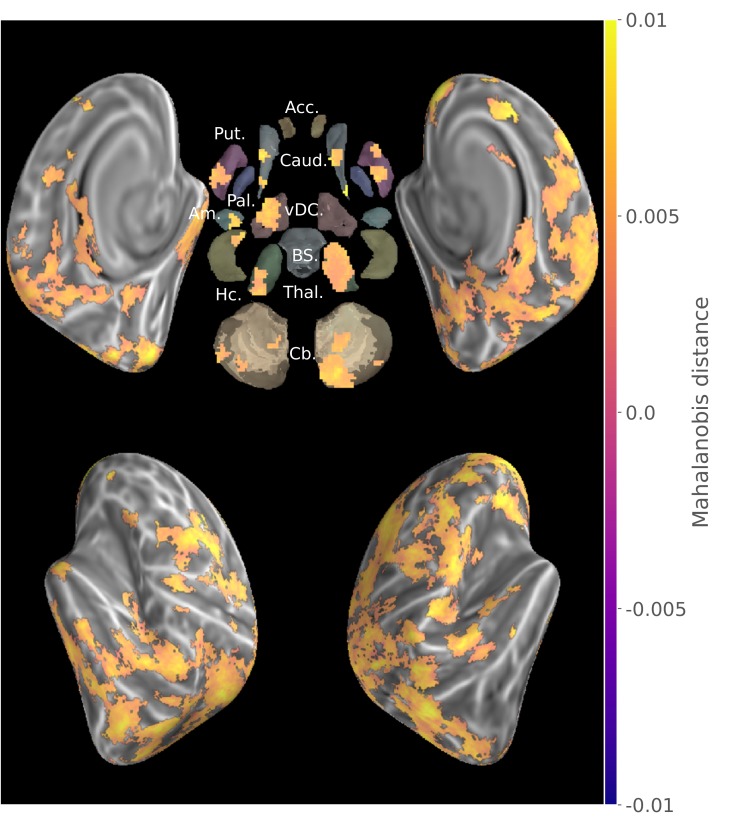
Group searchlight map of cross-validated Mahalanobis distance between the two consolidated sequences (z-score thresholded at p < .05 TFCE-cluster-corrected).